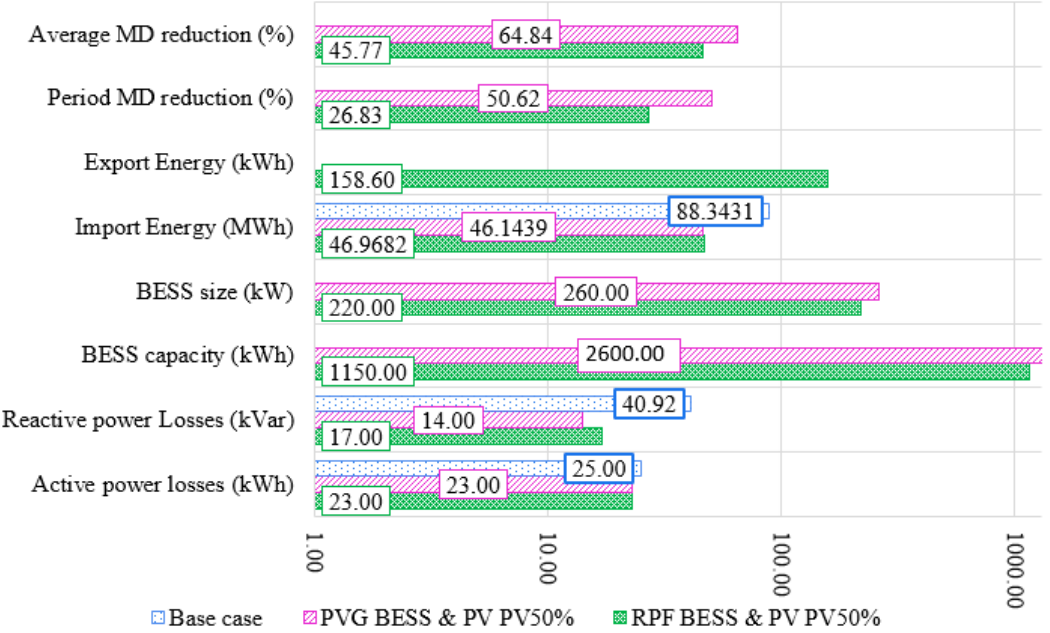
Figure A2. Comparison of PVGS and RPFS with 50% PV penetration level (January 2016).